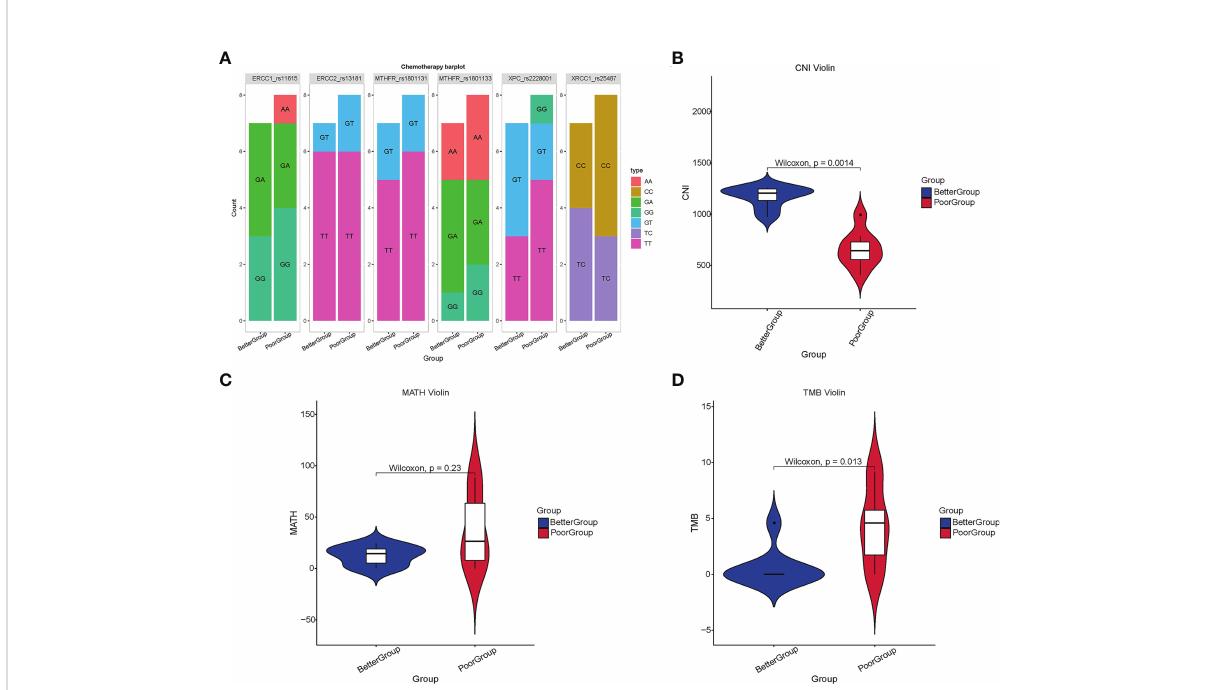
FIGURE 3 Analysis of chemotherapy-related loci, CNI, MATH, and TMB in different therapeutic response groups. (A) The commonly used target genotypes of chemotherapy in 16 RC patients. (B) The CNI value in the better group was signi fi cantly higher than that in the poor group ( p = 0.0014) (C) There was no signi fi cant difference in the MATH value between the two groups ( p = 0.23). (D) The TMB in the poor group was signi fi cantly higher than that in the better group ( p =